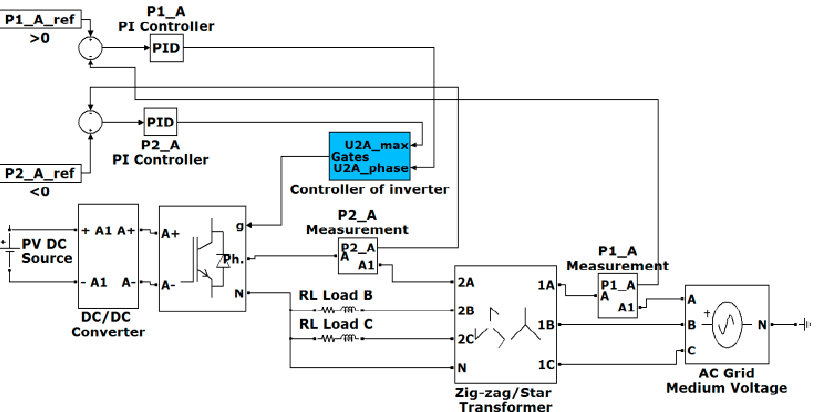
Figure 5. Diagram of control system P 1A and P 2A of Yz 0 transformer.